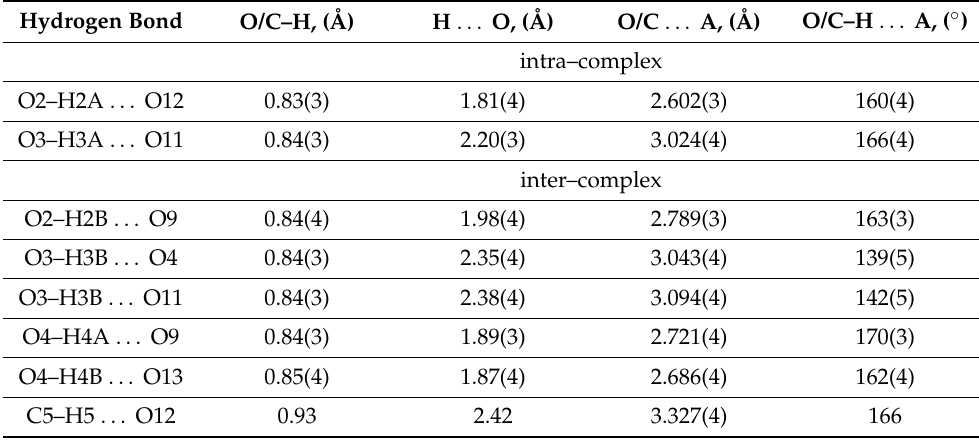
Table 2. Parameters of hydrogen bonds for [Ca(ChA)(H 2 O) 3 ] n